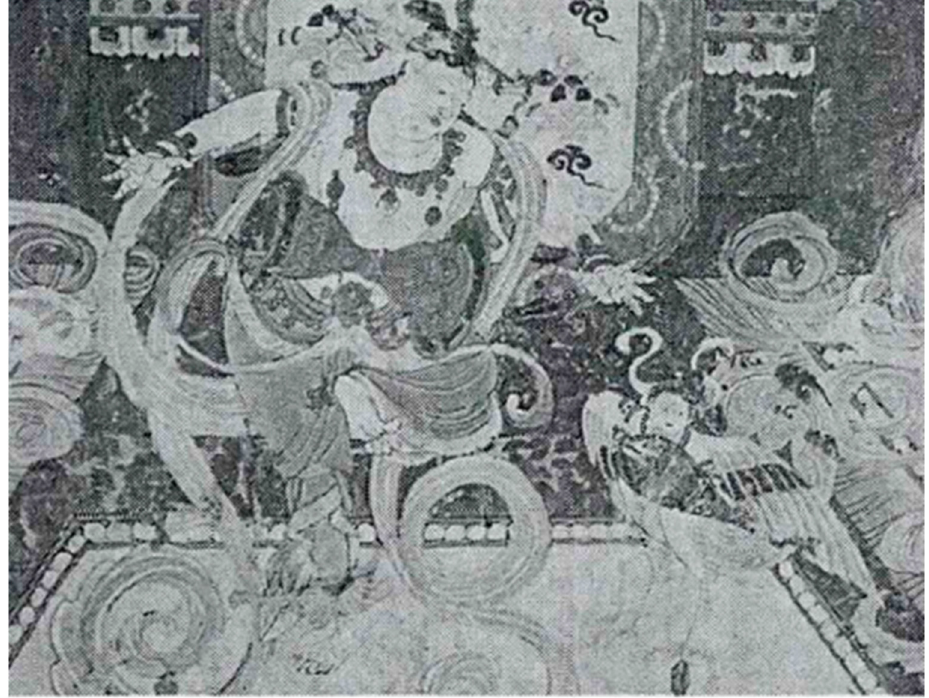
Figure 4. Partial image: The variation of the Sutra of the Visualization of the Amit ā yus S ū tra (Fo shuo guan wuliangshou fo jing 佛 说 观 无 量 寿 佛 經 or Guan jing 觀 經 ) from Cave 25 of the Yulin 榆 林 Cave in the Mogao Caves at Dunhuang (Zhang 2018, p. 21).